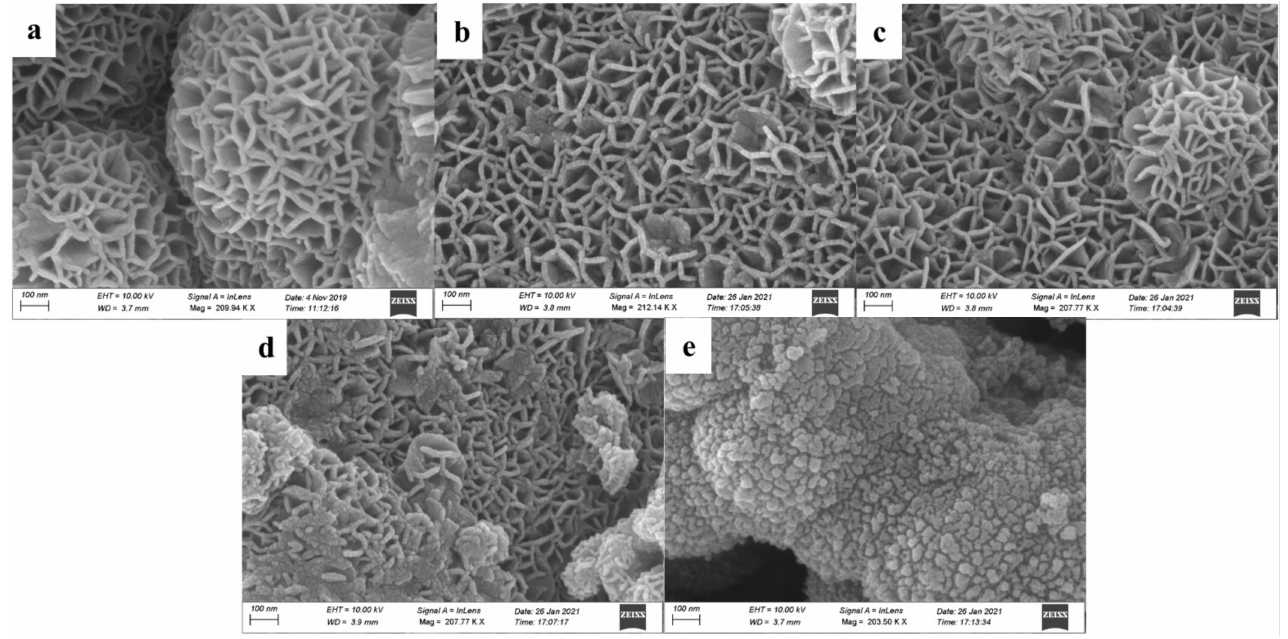
Figure 4. SEM images of the catalysts: ( a ) 7-MnO 2 , ( b ) 9-MnO 2 , ( c ) 11-MnO 2 , ( d ) 13-MnO 2 , and ( e ) 14-MnO 2